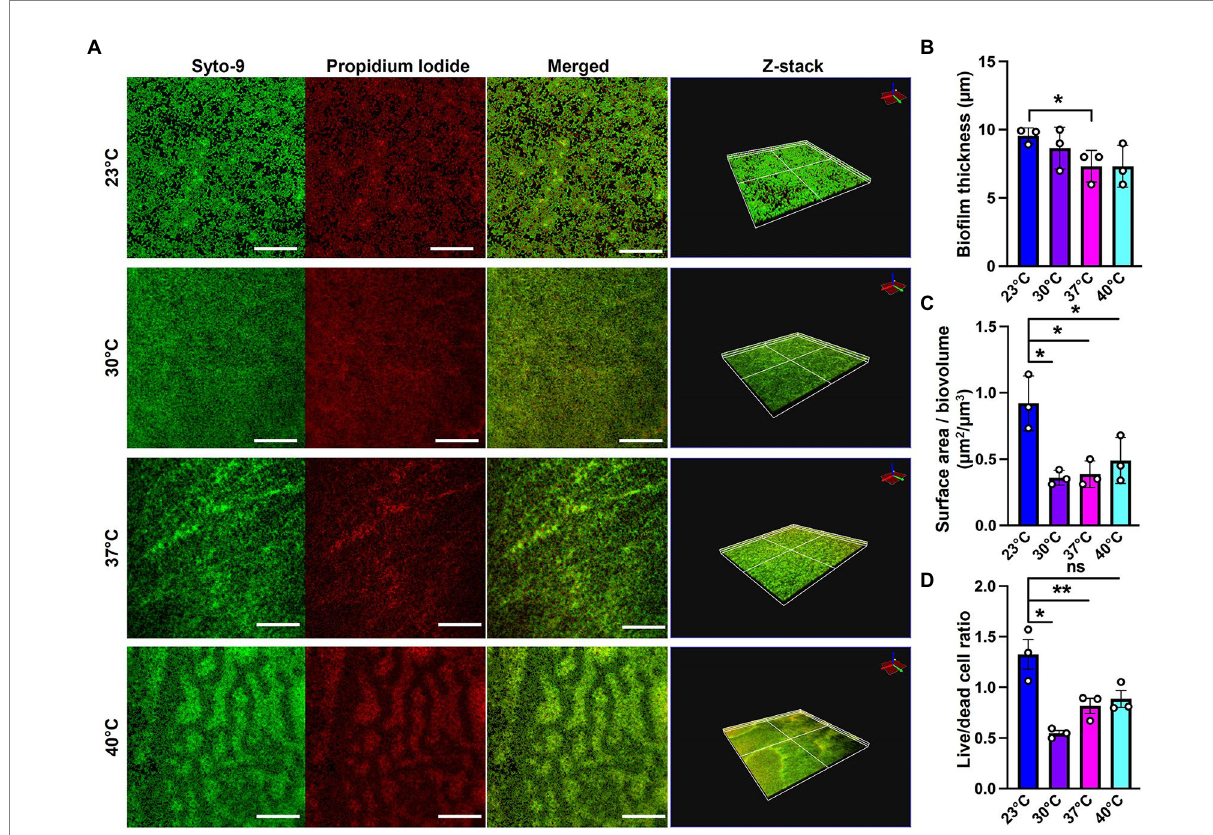
FIGURE 4 Microscopy using EPS-specific stains reveals temperature-induced structural changes in P. aeruginosa biofilms. (A) The live/dead staining results of P. aeruginosa PA14 biofilm after 48 h of growth at 23 ° C, 30 ° C, 37 ° C and 40 ° C. Biofilm was grown for 48 h on a microscope glass slide at 23 ° C, 30 ° C, 37 ° C and 40 ° C and stained with FilmTracer LIVE/DEAD Biofilm Viability kit; SYTO 9 shows live cells in green and propidium iodide shows dead cells in red. Scale bar: 50 μ m. Z-stacks were collected for biofilms at the four temperatures using CLSM and analyzed by COMSTAT2 to determine. (B) The biofilm thickness and (C) the surface area to biovolume. (D) Live/dead cell ratio was analyzed using ImageJ. Images are representative of three independent experiments. Unpaired t-test (two-tailed) was used to measure statistical significance. ns: not significant, * p ≤ 0.05, and ** p ≤